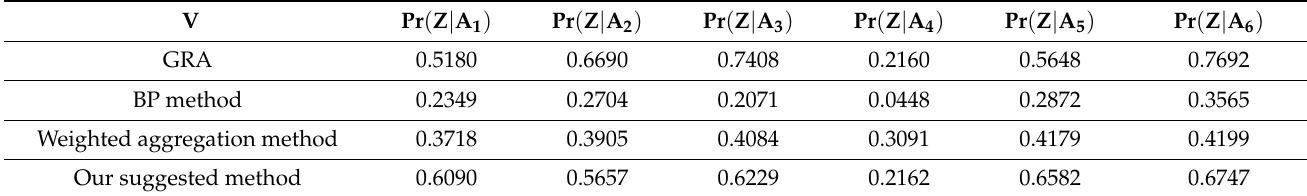
Figure 3. The comparison between our proposed technique and GRA, BP, and weighted aggregation methods. Table 10. The outcomes of conditional probability by using MADM methods.